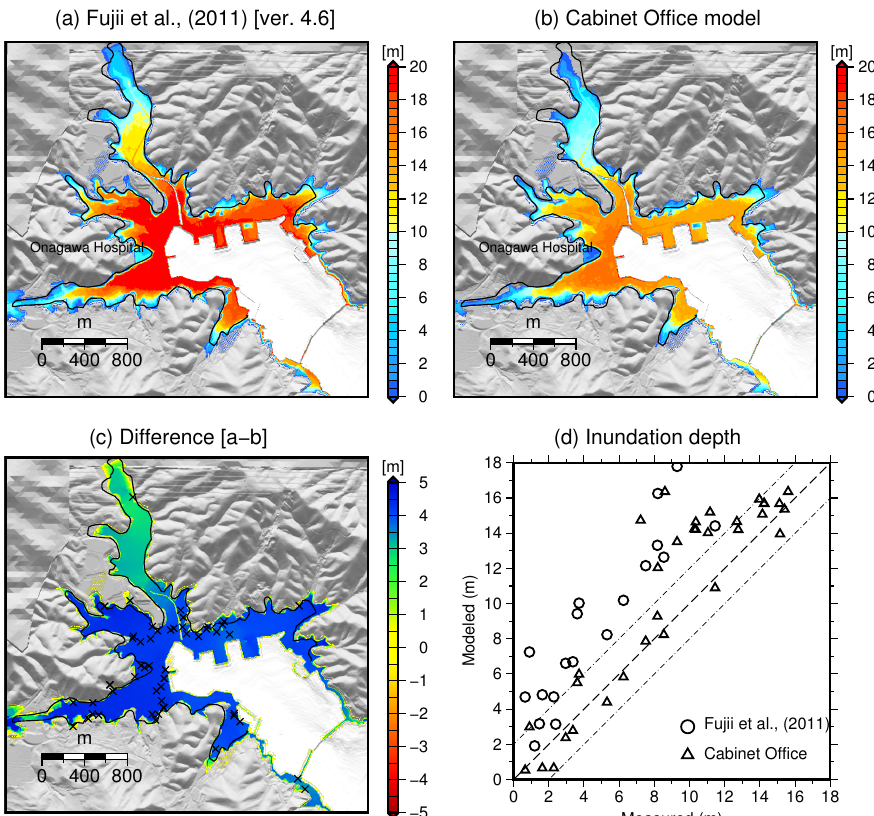
Figure 6. Onagawa computational area. ( a ) Maximum inundation depth computed using the tsunami source published by Fujii et al. [1]; ( b ) Maximum inundation depth estimated using the earthquake source developed by the Cabinet Office of Japan (Cabinet Office 2012); ( c ) Difference in the maximum inundation depth between the Fujii et al. [1] and the Cabinet Office [9] models. The x symbols show the locations of the Japan Society of Civil Engineers (JSCE) measurements. The black line indicates the inundation limits estimated by the Geospatial Information Authority of Japan (GSI); ( d ) Comparison between the JSCE field survey data and the computed inundation depths. The triangles and circles show the computed inundation depths using the Fujii et al. [1] model and the Cabinet Office [1] model,